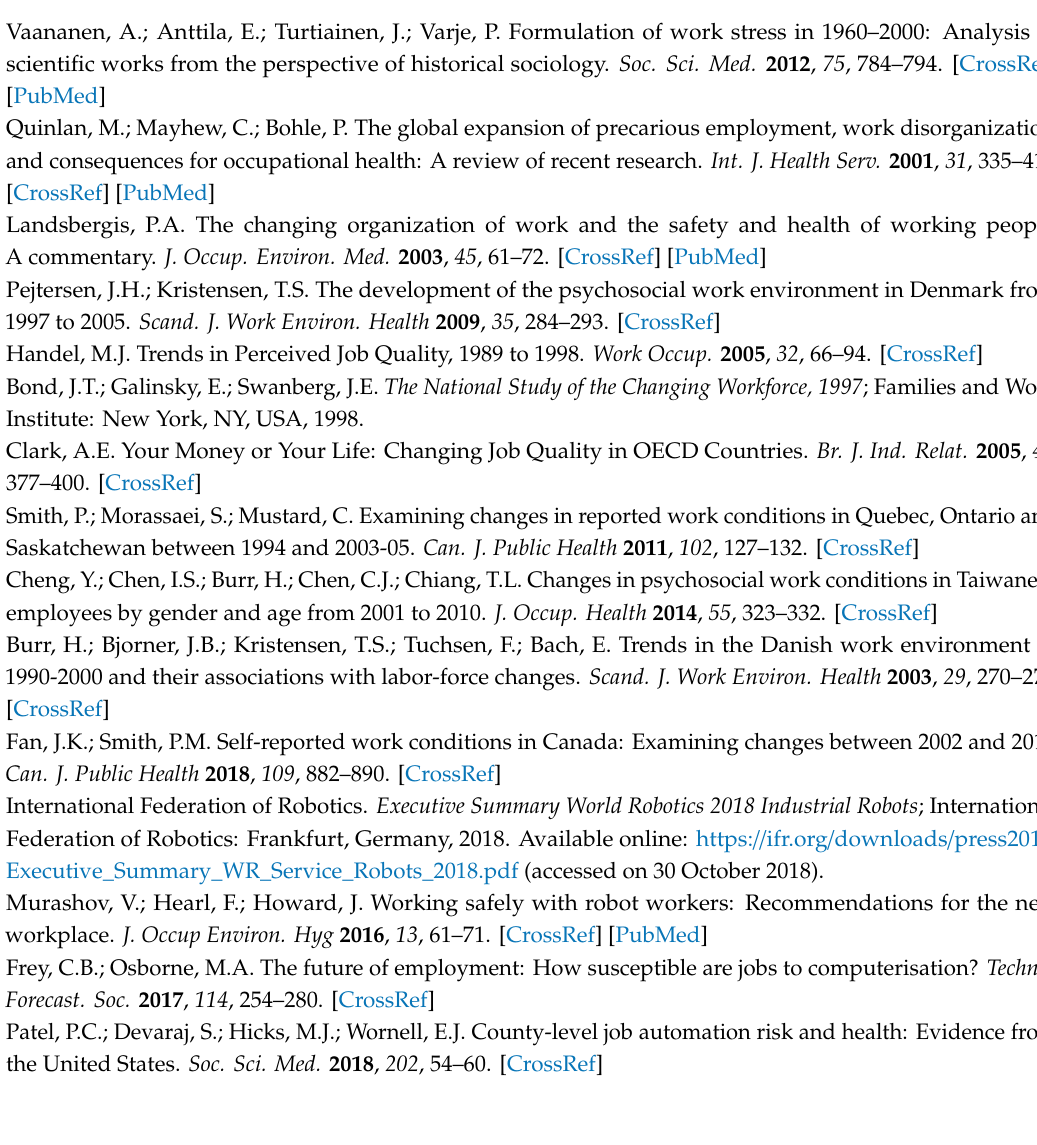
Table S1: Description of demographic characteristics, work conditions, and health indicators of workers from 2001 to 2016, stratified by automation probability of jobs. P value for trend analysis tests were